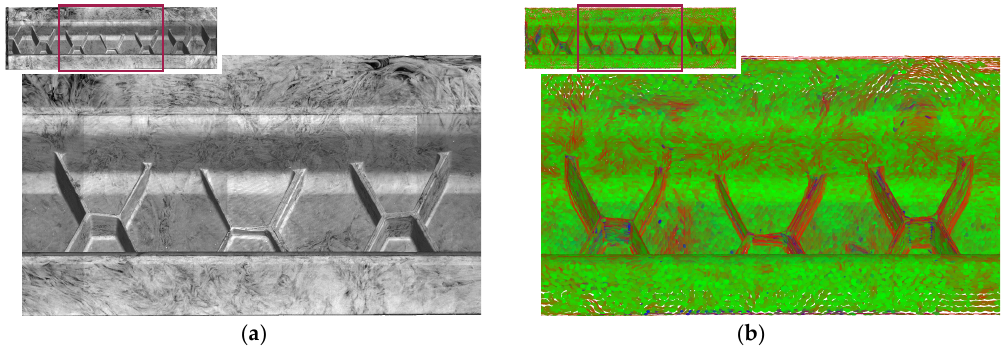
Figure 23. ( a ) Detailed 3D view of the CT scanned ribbed structure #20 (displayed are density gradients at the part surface; the surface of the hat brims is slightly removed to show the carbon fiber bundle orientations inside the brims); ( b ) determined FOTs of the same part displayed as ellipsoids in VGSTUDIO MAX 3.3 (analysis based on the process simulation tetra mesh; CT scan data are set to 100% transparency) (red elongated ellipsoids: fibers highly oriented in one direction, green flattened ellipsoids: planar fiber orientation, blue spherical ellipsoids: 3D random fiber orientation).